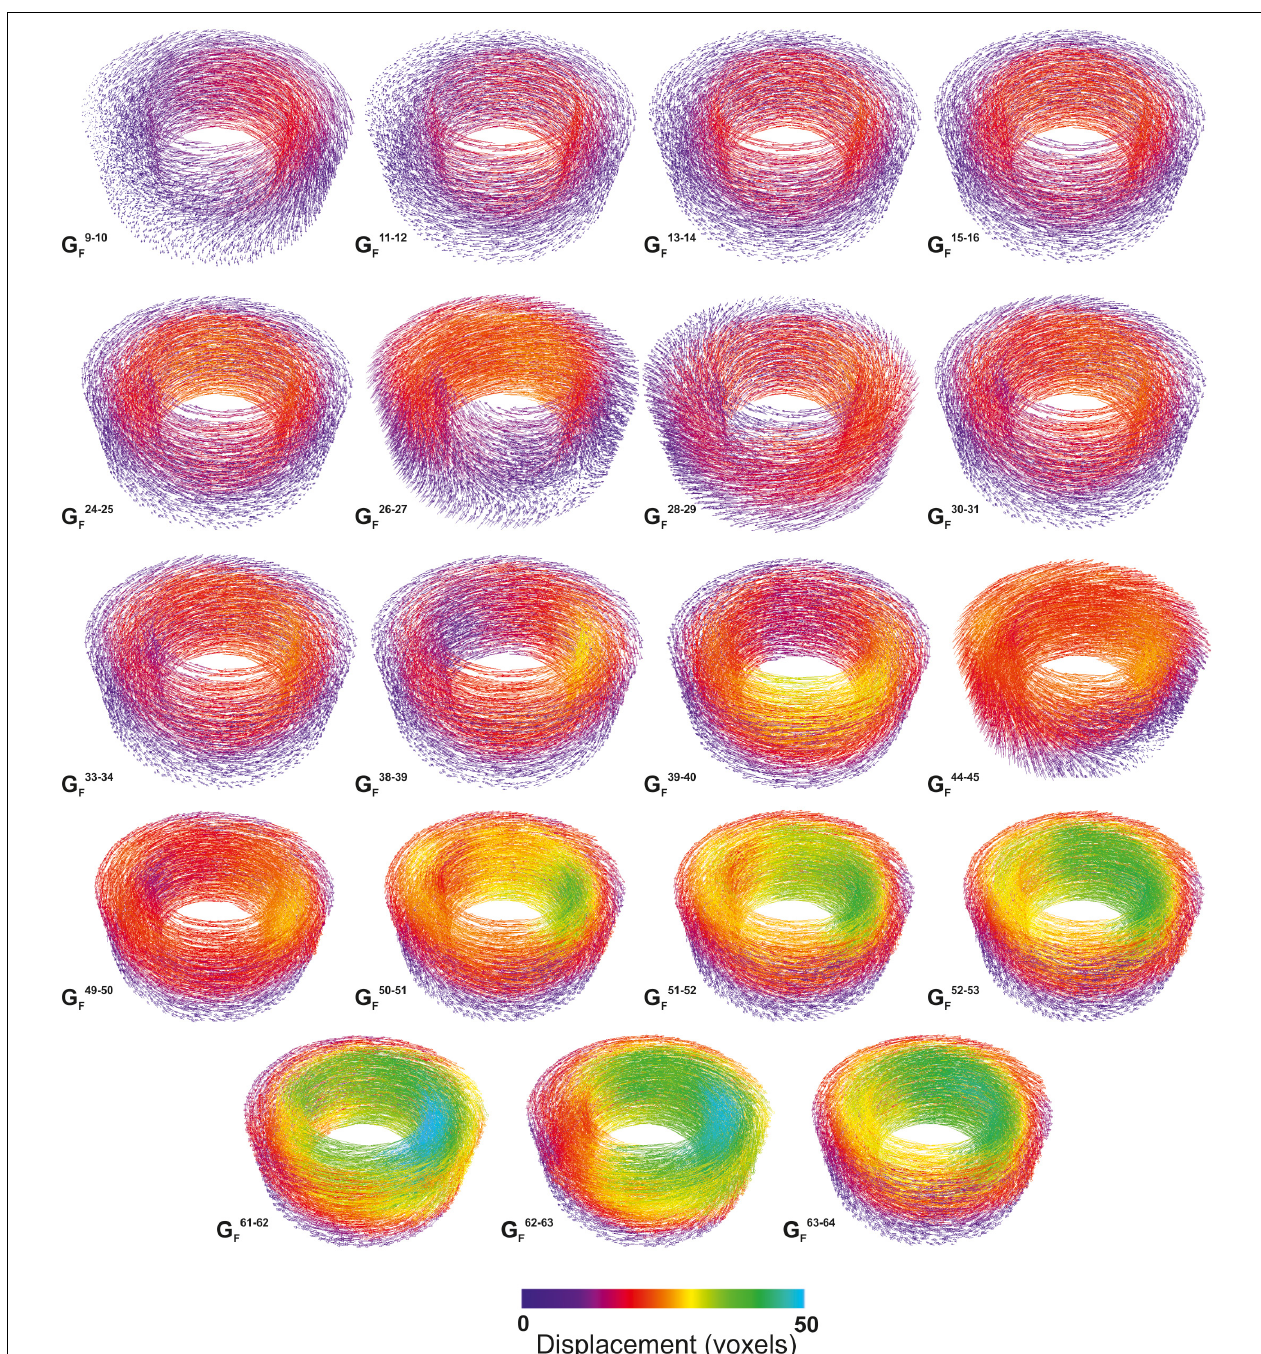
FIGURE 11 | DVC outputs from the start of the acceleration phase. Note the discontinuous time steps shown. Workflow for iterations as shown in Figure 10 . The outputs shown were those generated on the experiment discussed in section “Bubble Bearing Magma (High Temperature)” and shown in Figures 6 , 7